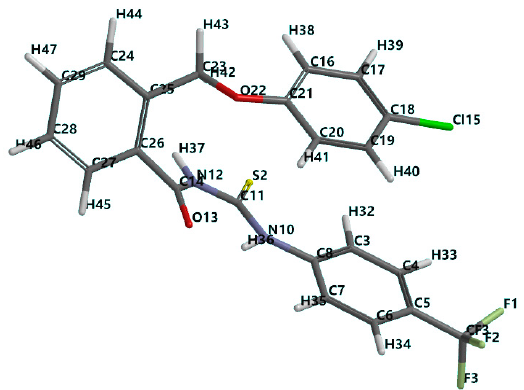
Figure 3. Tube representation of the optimized molecular structure of 2-((4-chlorophenoxy)methyl)-N-(4-trifluoromethylphenylcarbamothioyl)benzamide ( 1g ). (the numbering of the atoms was done according to the software)